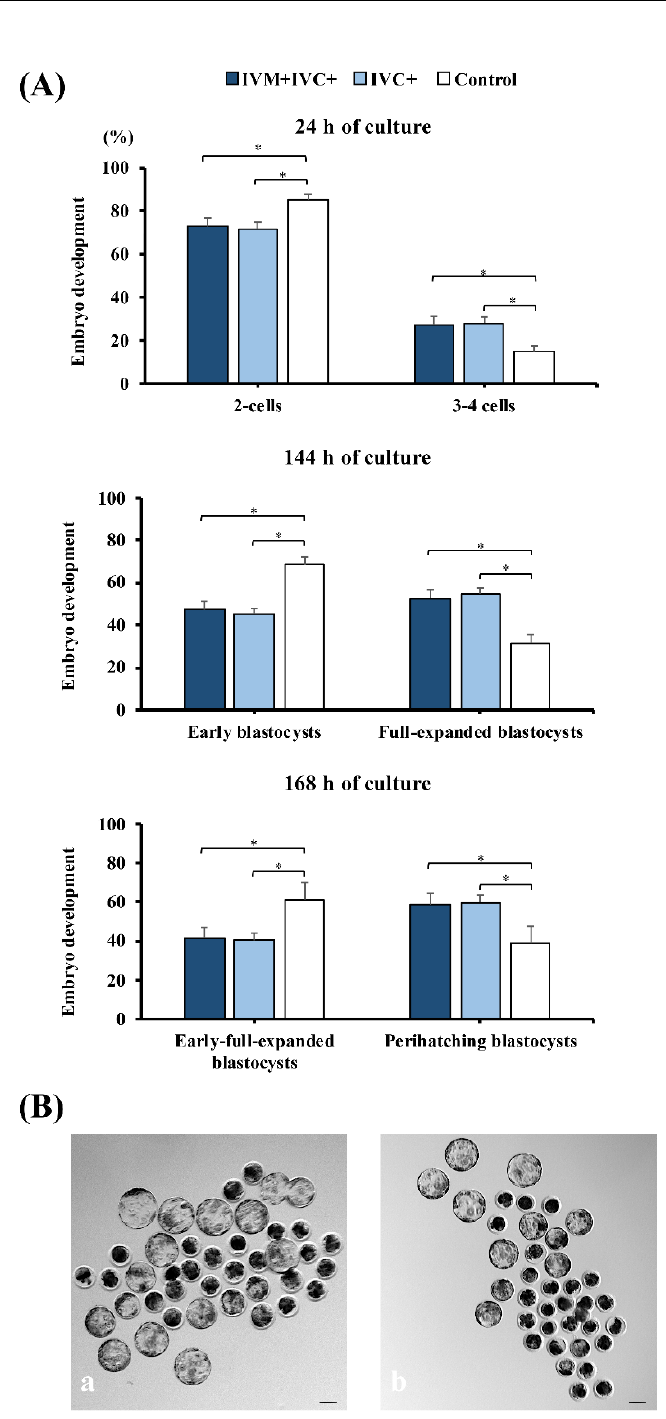
Figure 7. Embryonic developmental stages at 24 h, 144 h, and 168 h of culture were achieved by oocytes and embryos exposed or not exposed (control) to 1 nM melatonin. ( A ) Percentages of 3, 4-cell embryos at 24 h of culture from the total number of cleaved embryos at 48 h of culture and distribution of the different blastocyst stages reached in each group at 144 h and 168 h of culture, respectively. IVM + IVC+ group ( n = 323): maturation and embryo culture performed in media supplemented with melatonin; IVC+ group ( n = 310): embryo culture performed in medium containing melatonin. Control group ( n = 295): maturation and embryo culture performed without melatonin. Perihatching blastocysts include hatching and hatched blastocysts. * p < 0.05. Data are presented as the means ± SEM (four replicates). ( B ) Representative images of blastocyst development at 168 h of culture in the presence ( a ) or absence ( b ) of melatonin. Scale bar: 100 µm.